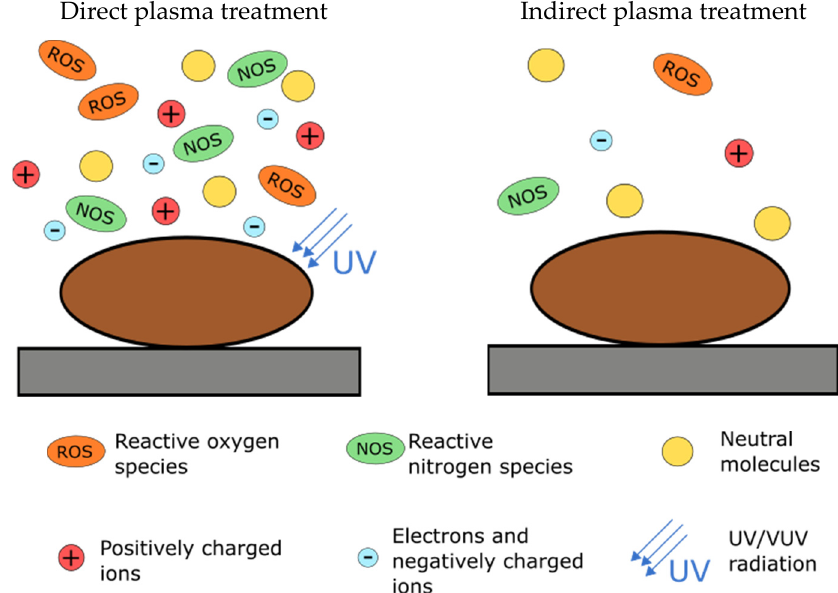
Figure 3. Schematic representation of particles occurring in direct and indirect plasma treatment region. Direct plasma treatment region is a combination of positively and negatively charged particles, neutral chemical species, ROS, NOS and UV radiation. In indirect plasma treatment, however, only lower, less aggressive concentrations of reactive chemical species are present.